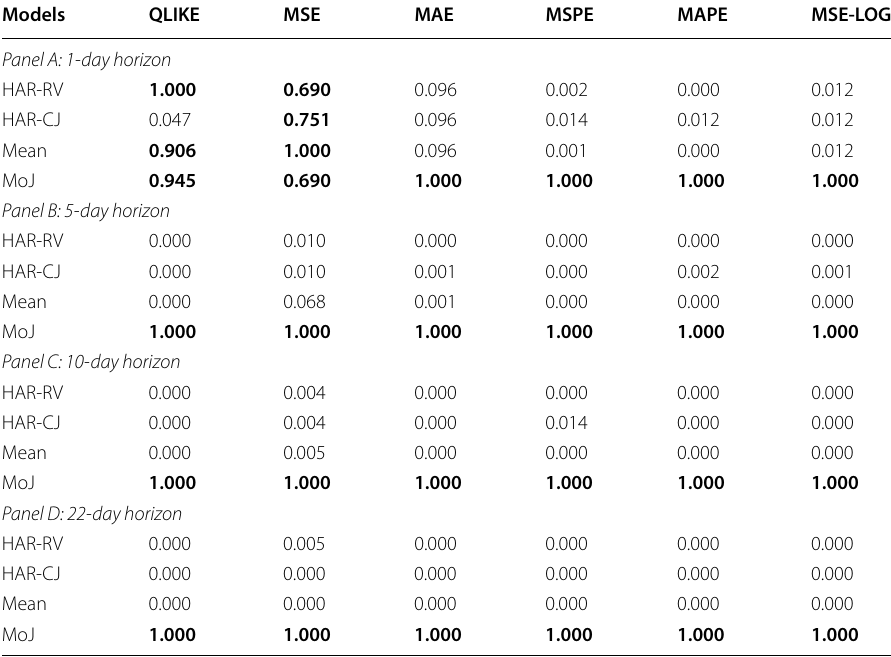
Table 11 MCS out-of-sample forecasting test for stock market